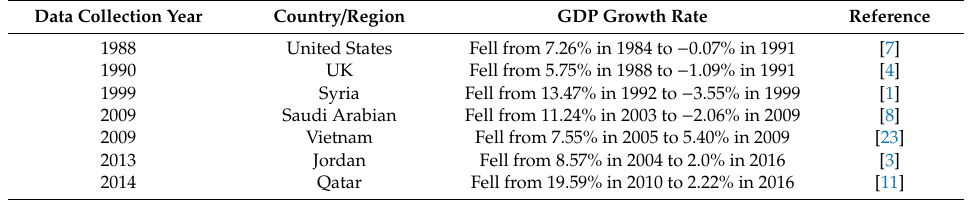
Table 2. The economic downturn extent in previous studies on contractors’ bid / no-bid decision factors. Data Collection Year Country / Region GDP Growth Rate Reference 1988 United States Fell from 7.26% in 1984 to − 0.07% in 1991 [7] 1990 UK Fell from 5.75% in 1988 to − 1.09% in 1991 [4] 1999 Syria Fell from 13.47% in 1992 to − 3.55% in 1999 [1] 2009 Saudi Arabian Fell from 11.24% in 2003 to − 2.06% in 2009 [8] 2009 Vietnam Fell from 7.55% in 2005 to 5.40% in 2009 [23] 2013 Jordan Fell from 8.57% in 2004 to 2.0% in 2016 [3] 2014 Qatar Fell from 19.59% in 2010 to 2.22% in 2016